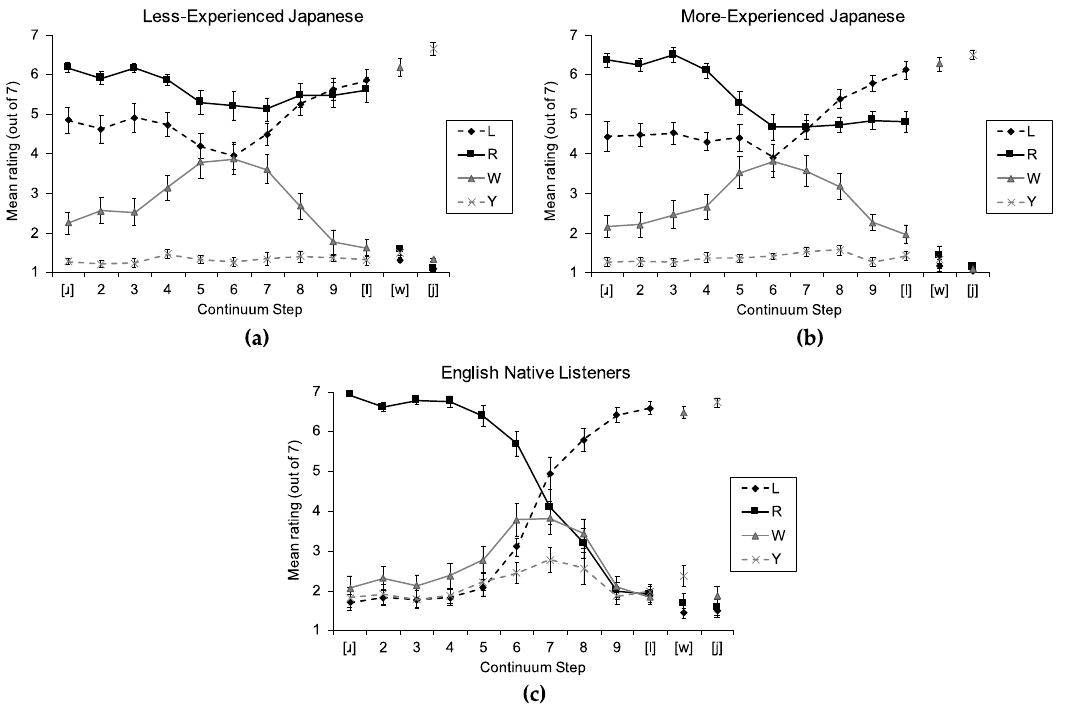
Figure 1. Mean forced goodness ratings for each auditory stimulus, to /l/ (L), /r/ (R), /w/ (W), and /j/ (Y) categories, where 1 is “highly dissimilar” and 7 “highly similar”. ( a ). Less experienced Japanese (<3 months immersion); ( b ) More experienced Japanese (>2 years immersion); ( c ) Native English listeners. Error bars represent standard error of the mean.